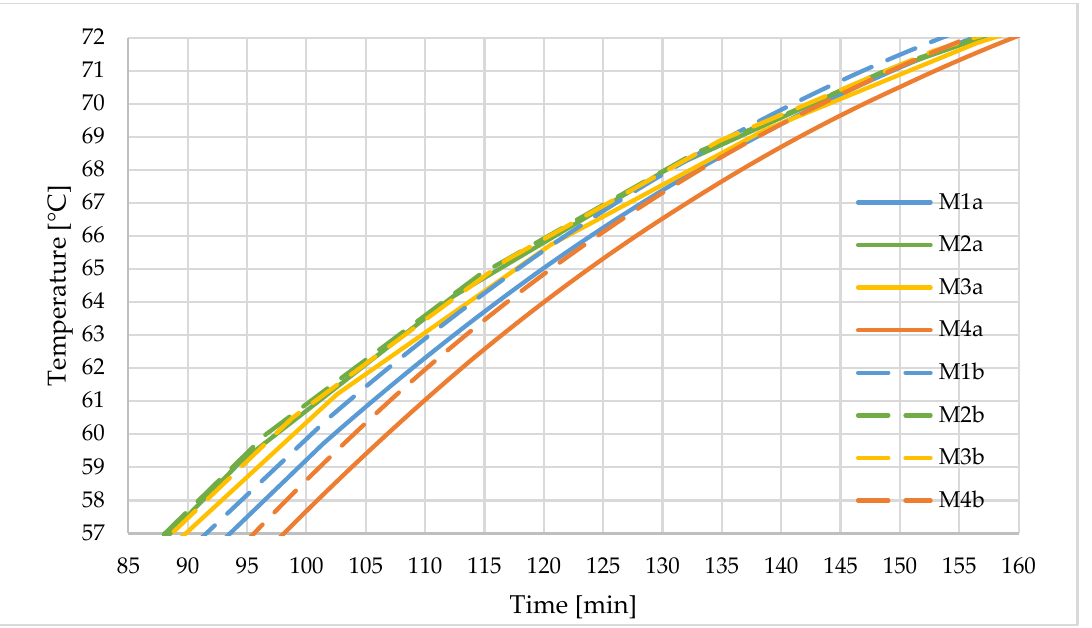
Figure 10. Temperature over time in the center of the tubes in Models 1 – 4 for velocity 1 m/s (a), and 4 m/s (b).